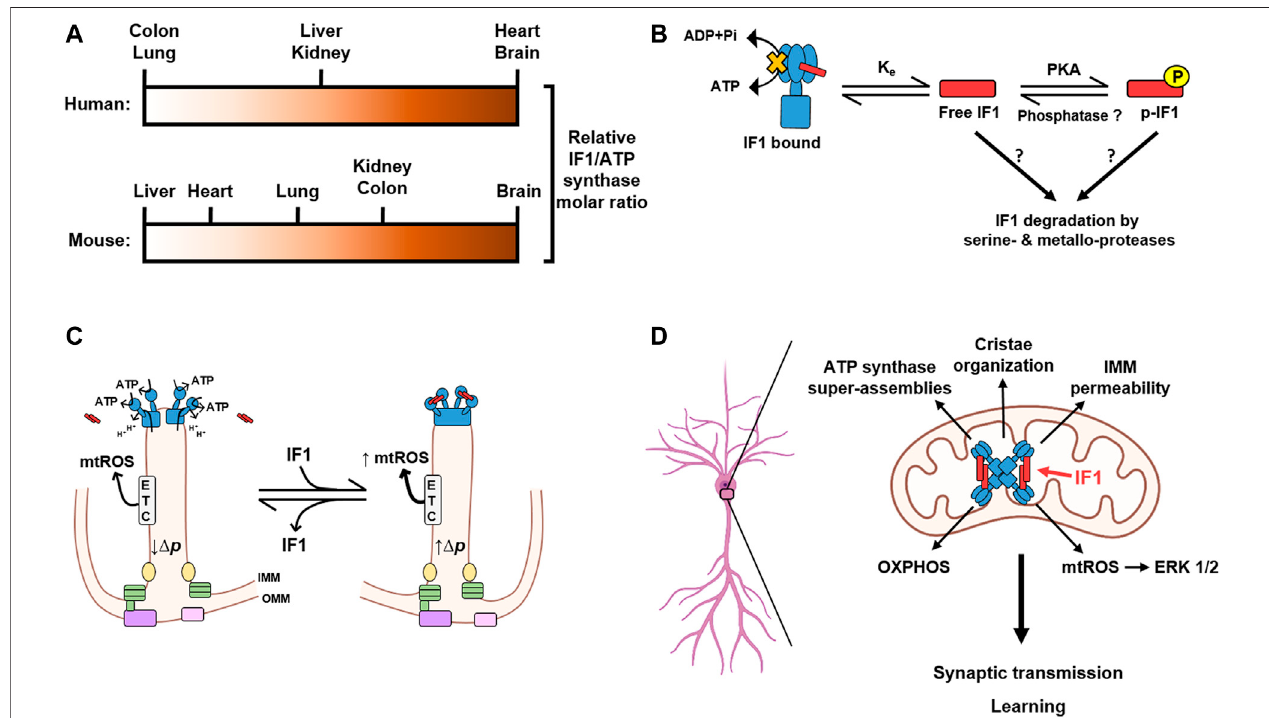
FIGURE 2 | IF1 is tissue-speci fi cally expressed and plays a central role in neuronal function and learning. (A) The relative molar ratio between IF1 and the ATP synthasevariesindifferenttissuesandbetweenhuman(above)andmouse(below).NegligibleIF1expression,white;Highestratio,darkbrown. (B) InteractionofIF1with the ATP synthase is a reversible process mainly dependent on the mitochondrial content of dephosphorylated and free IF1. IF1 is phosphorylated by a mitochondrial protein kinase A (PKA)-like activity, thus reducing the amount of free IF1 that can bind to the enzyme. No phosphatases have been yet found to mediate IF1 dephosphorylation. An additional actor affecting the binding equilibrium of IF1 (Ke) might be the rapid turnover of IF1 mediated by serine- and metallo-proteases. (C) Cartoon illustrating the major effects of IF1 binding to ATP synthase in its activity and in generating the tetrameric structure of the enzyme to facilitate the formation of cristae rims. Bindingof IF1(red) todimers ofthe ATP synthase (blue) generatetetramers ofinhibited enzyme leading toincreased proton-motiveforce ( Δ p ) in cristae and the generation of mitochondrial ROS (mtROS) by the electron transport chain (ETC). Other components that facilitate cristae structure such as the MICOS complex (green), mitochondrial dynamin-like GTPase (OPA1, yellow), the sorting and assembly machinery (SAM, purple) and translocase of the outer membrane (TOM, pink) located at the inner boundary membrane are depicted. (D) The expression of IF1 in hippocampal neurons promotes the formation of super-assemblies of the ATP synthase and thereby contributes to the organization of mitochondrial cristae and the permeability of the inner mitochondrial membrane (IMM). Moreover, IF1 plays a crucial role in the control of oxidative phosphorylation (OXPHOS) and signaling mediated by mitochondrial reactive oxygen species (mtROS), which activate the extracellular signal-regulated kinases (ERK) 1/2. By modulating these processes, IF1 emerges as a relevant protein for the regulation of synaptic transmission and learning. Image produced with